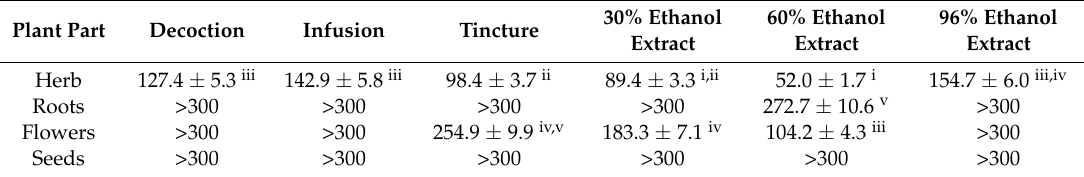
Table 1. Inhibitory effect on α -glucosidase of Comarum palustre extracts (IC 50 , µ g/mL) a,b